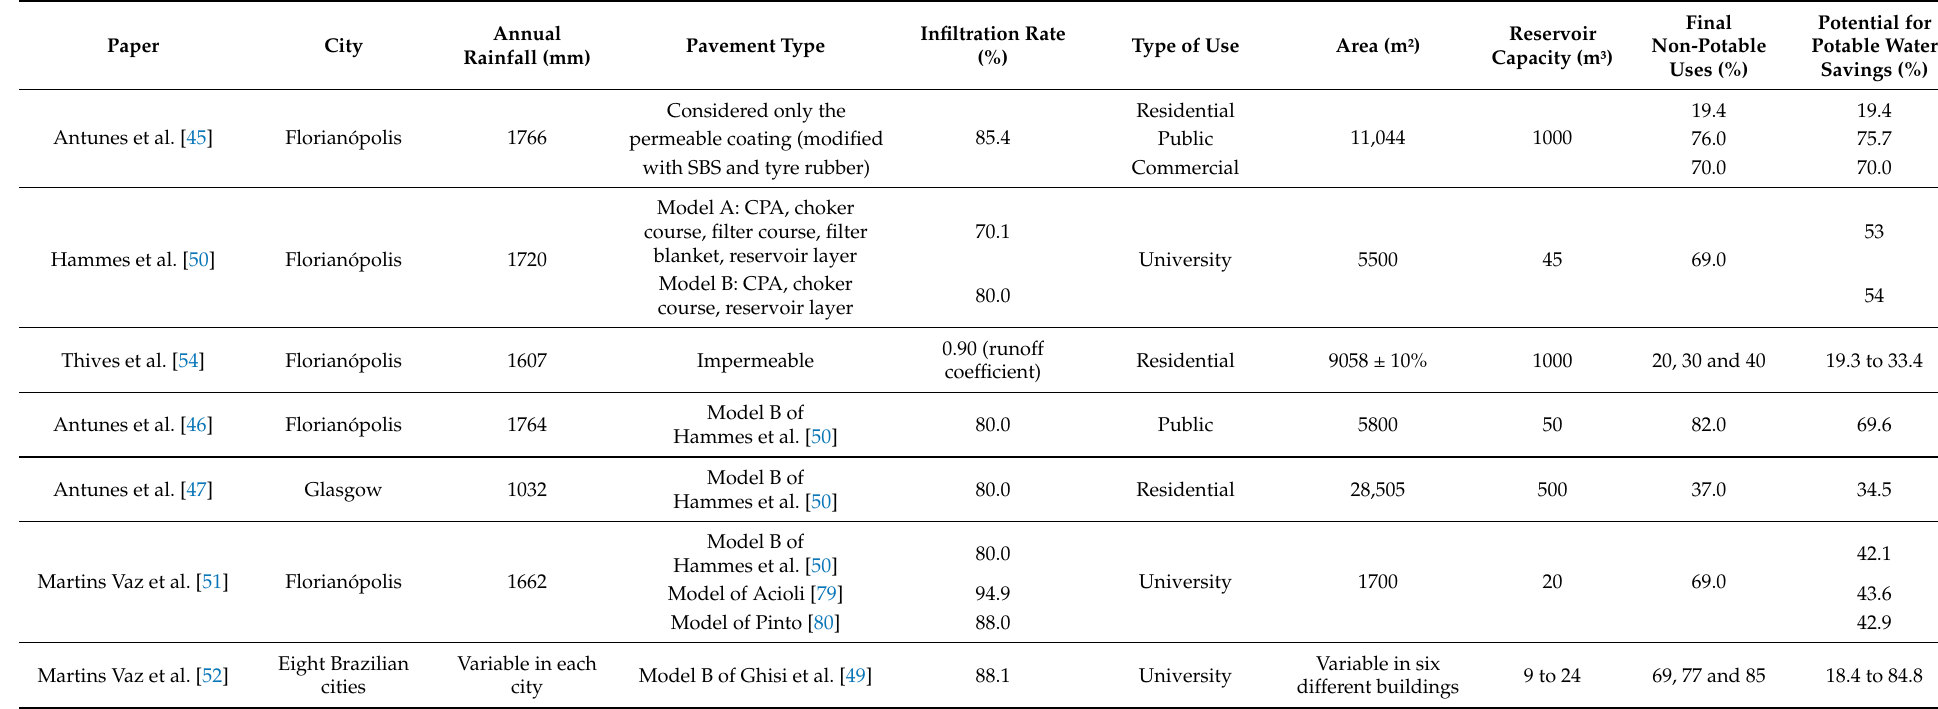
Table 5. Potential for potable water savings and simulations of the selected